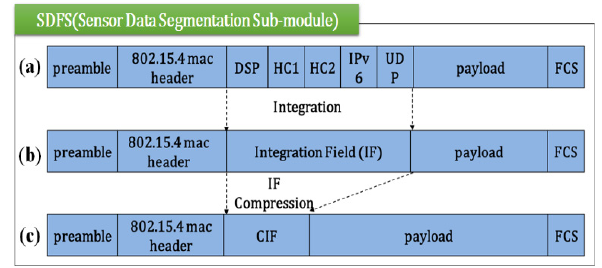
Figure 6. The fragment using a compressed integration field (CIF).